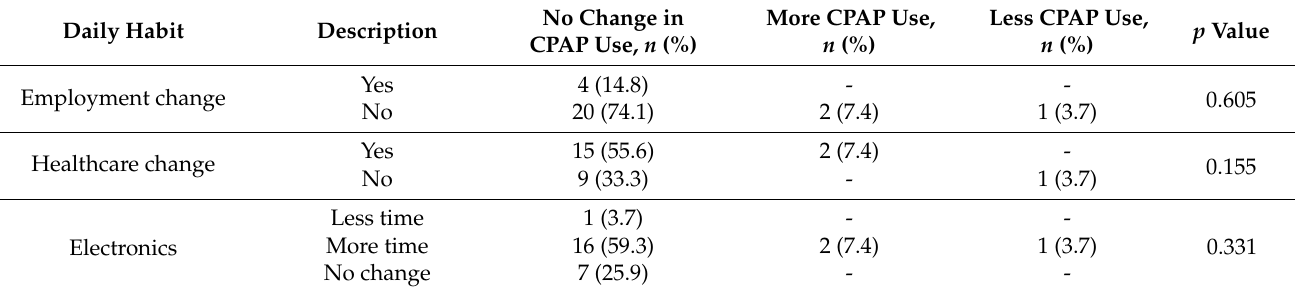
Table 4. Analysis of changes in daily habits during the COVID-19 pandemic and CPAP